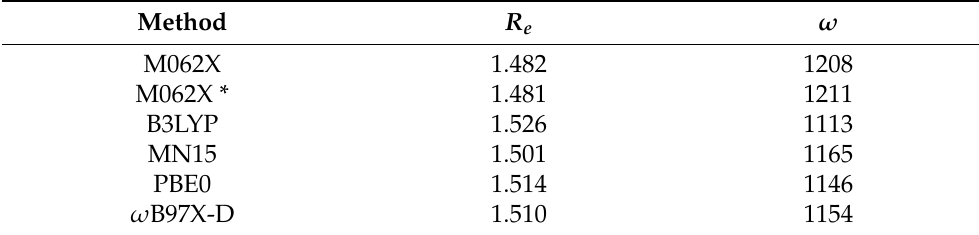
Table 1. Equilibrium Fe-C distance ( R e , in Å) and harmonic vibrational Fe-C stretching frequencies (in cm − 1 ) computed with various DFT exchange-correlation functionals. The values reported with a “*” are taken from Reference [1] and reported here for comparison.